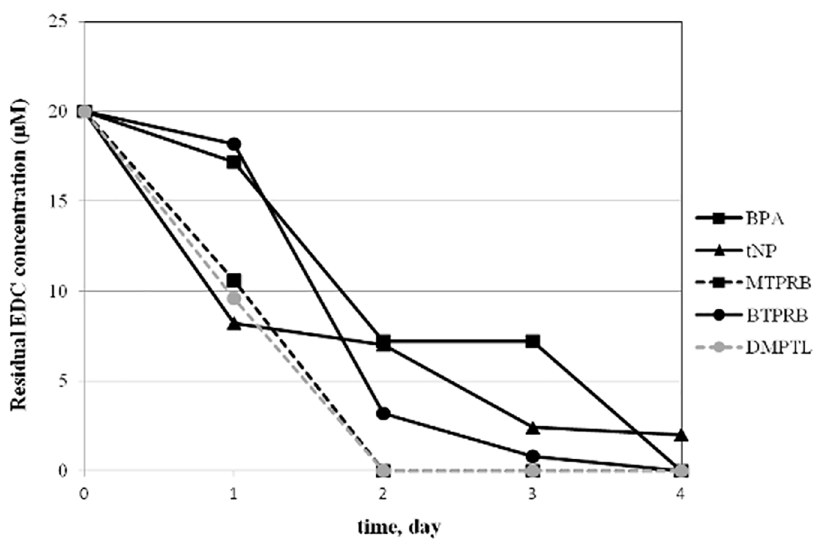
Fig 3. Residual EDCs concentration ( μ M) determined during treatment of EDC mixture by T . versicolor in RM. Standarddeviationsfrom three replicates of each series of results were less than ± 5%.